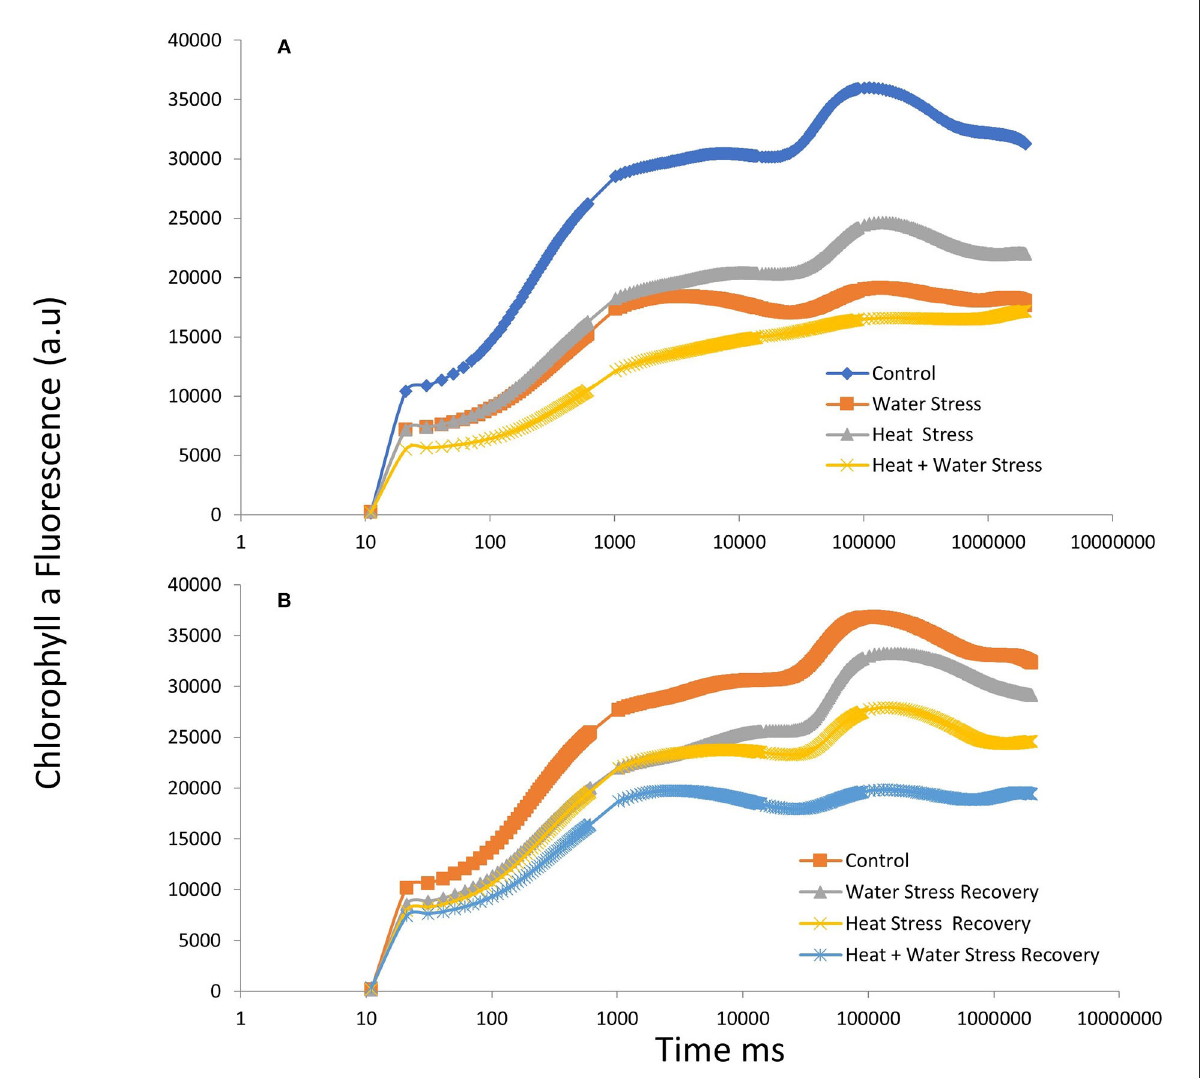
FIGURE2 OJIP chlorophyll a fluorescence transients in ICMH356 variety of pearl millet under water-deficit stress and heat stress in isolation and in combination (A) and at recovery from stress (B)